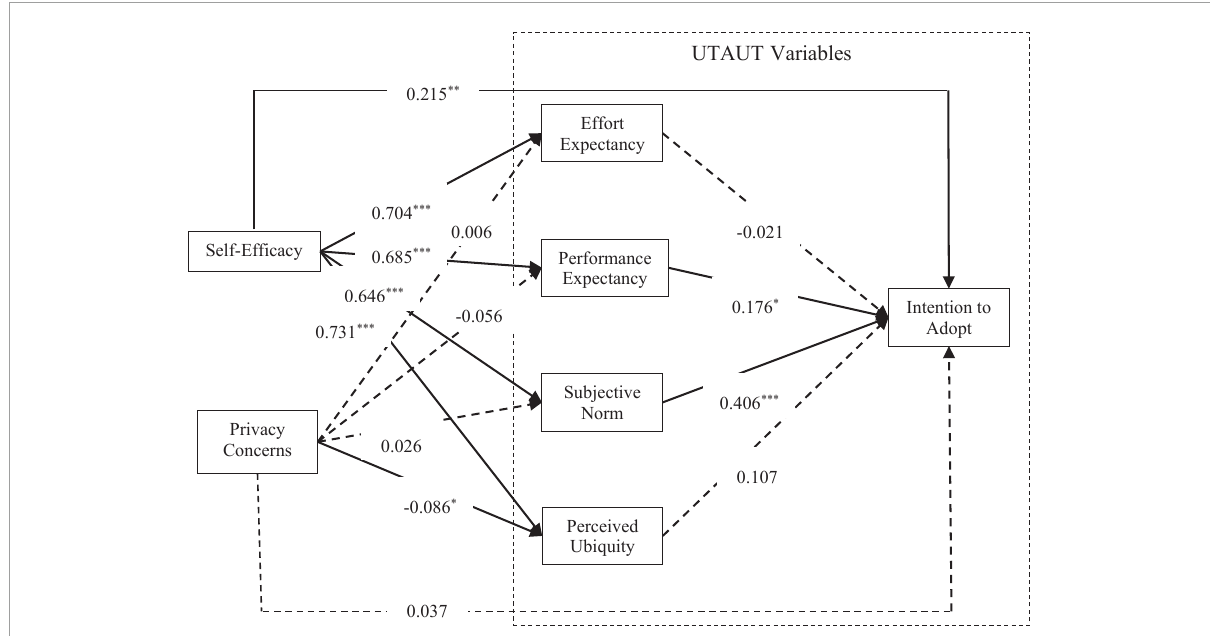
FIGURE3 The model of mHealth users’ intention to adopt before correction (standardized path coefficient). ∗ p < 0.05, ∗∗ p < 0.01, ∗∗∗ p < 0.001. The dotted line indicates that the path relationship is insignificant.